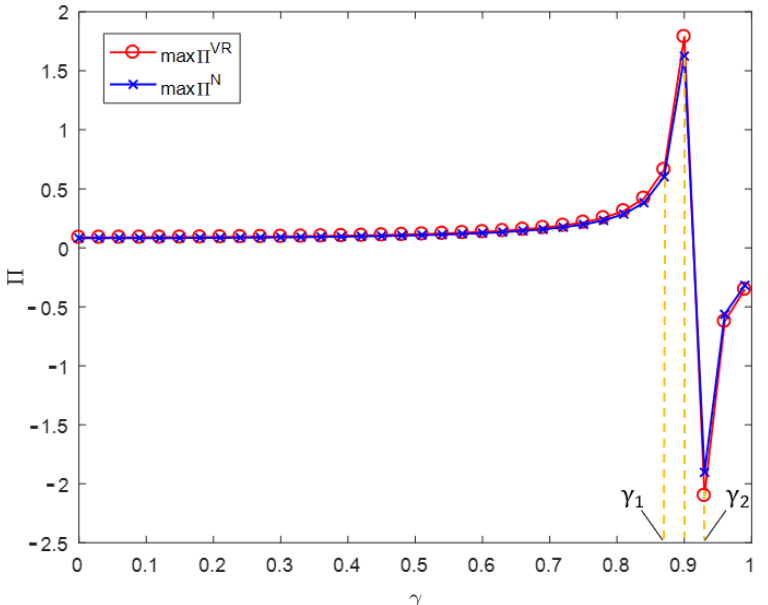
Figure 3. Impact on the total profit of the supply chain under centralized decision making.